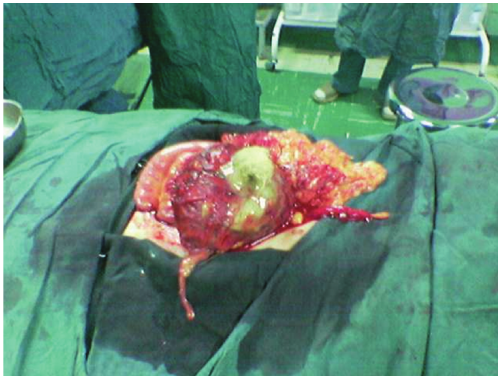
Figure 3: The gauze opened